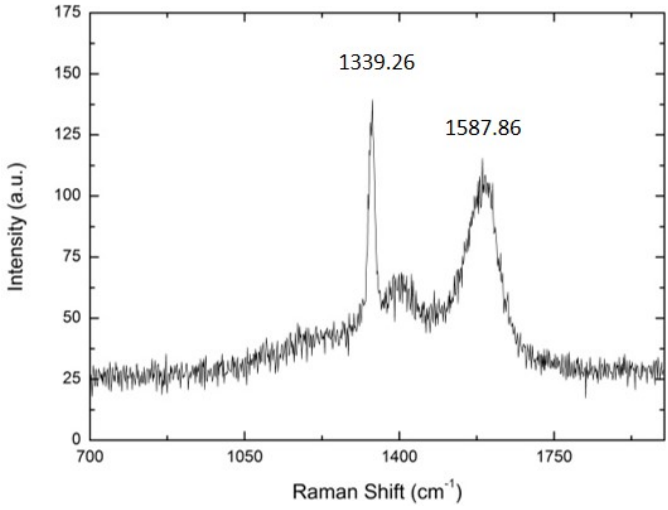
Figure 13. The Laser Cladding of VC Layers (LCVC) coating cross ‐ section processed at 600 dpi,